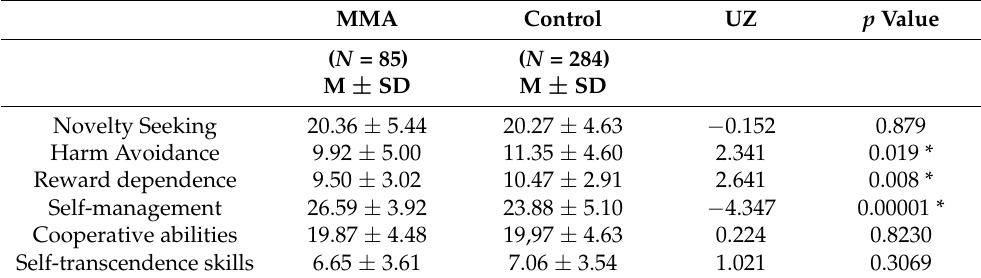
Table 4. Analysis of novelty seeking, harm avoidance, reward dependence, self-management, ability to cooperate and self-transcendence in MMA subjects and controls.